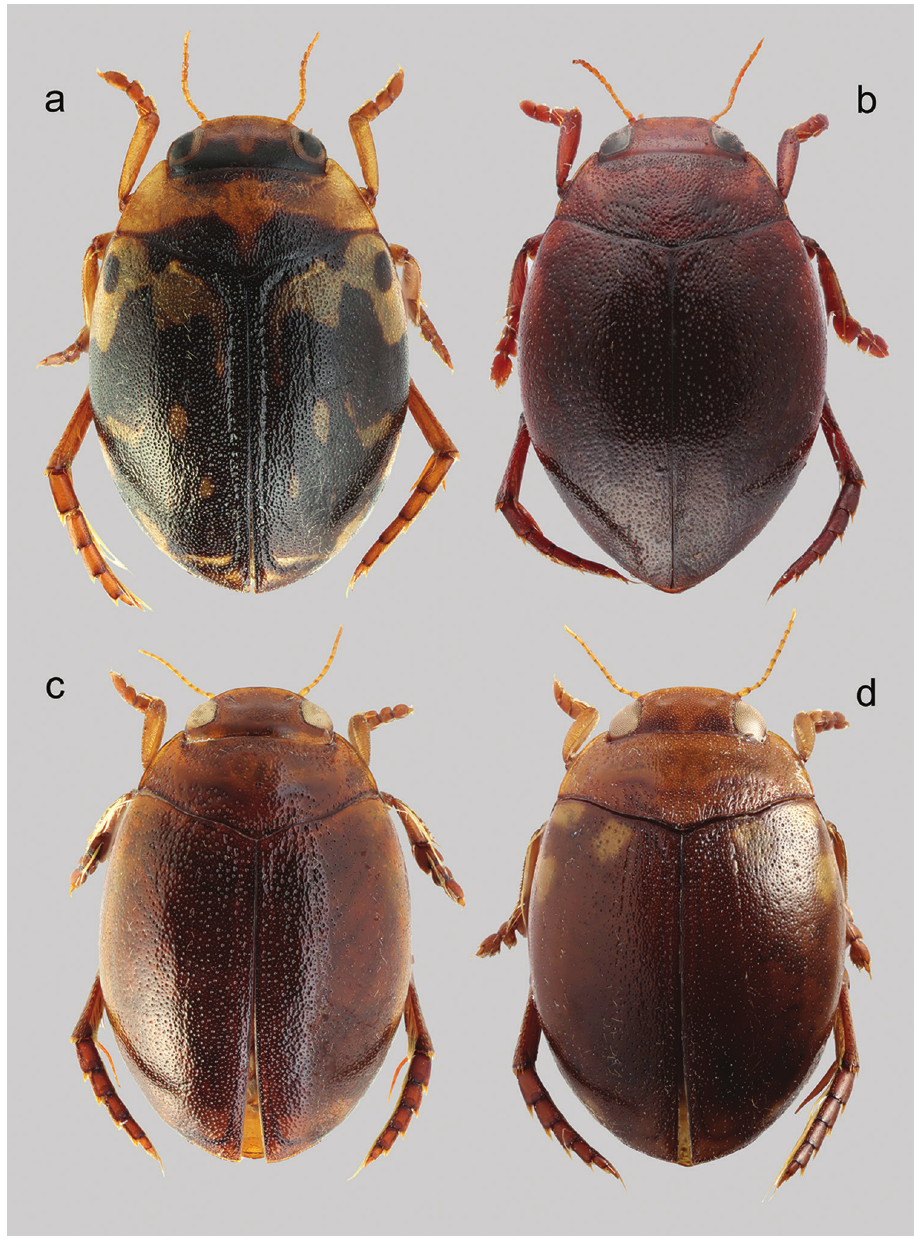
Figure 4. Hyphydrus male habitus. a H. aubei (Corsica; 4.9 mm) b H. ovatus (Sweden; 5.0 mm) c H. anatolicus (Slovakia, specimen post-extraction; 5.1 mm) d H. sanctus (Turkey; 5.2